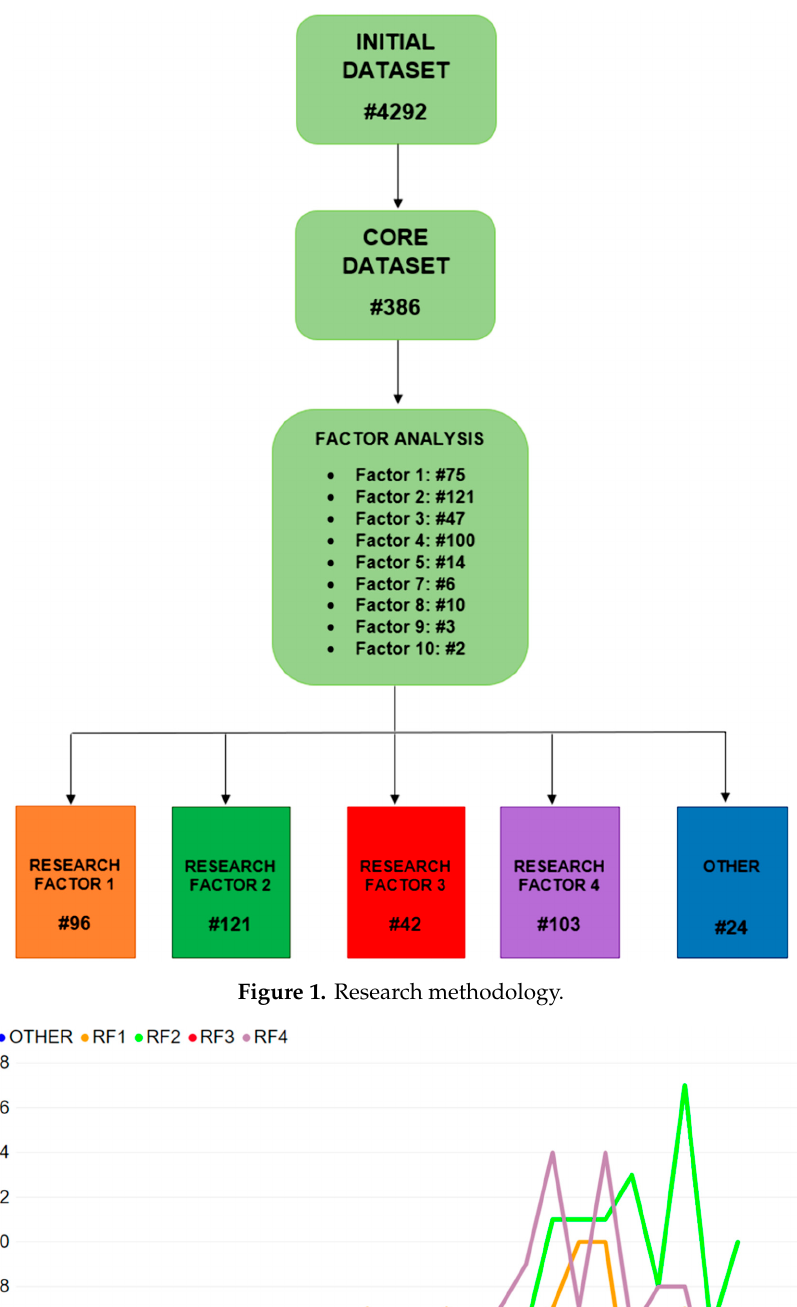
Figure 2. Temporal distribution of research factors (RF) using a histogram.